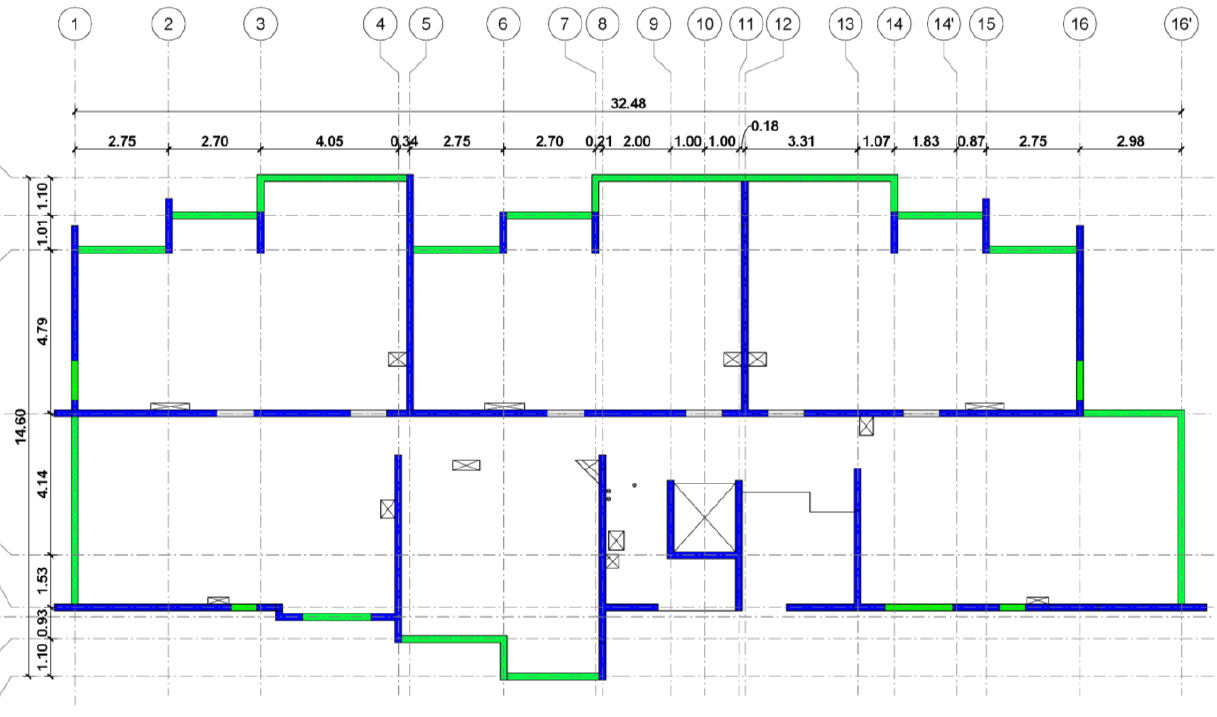
Figure 3. Elevation view of the section of the building in axis B.